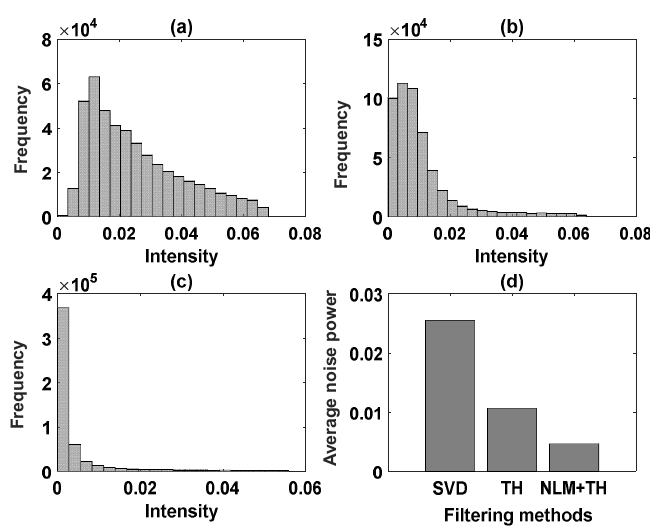
Figure 4. The intensity histogram comparison of noise level using ( a ) unbiased SVD, ( b ) SVD+TH, and ( c ) proposed method (NLM+TH); ( d ) average noise power for ( a – c ).